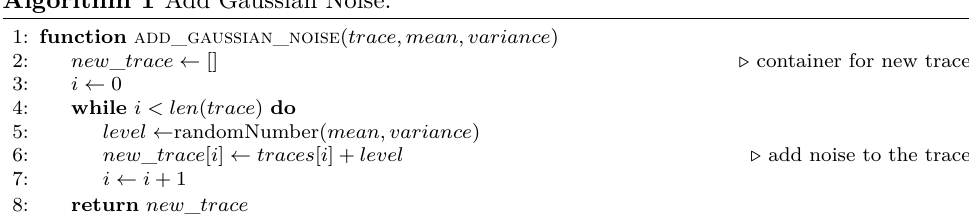
Algorithm 1 Add Gaussian